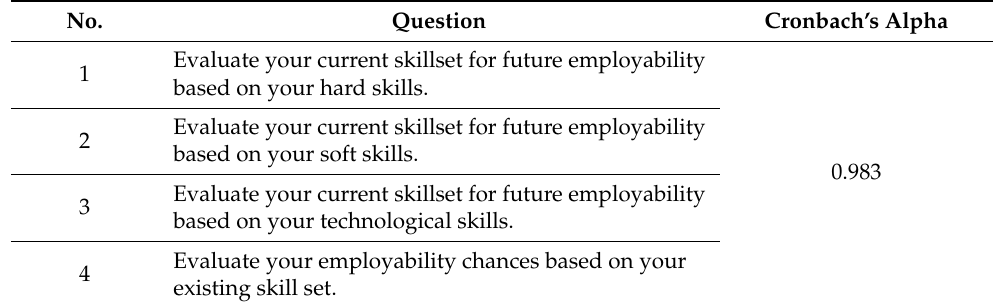
Table 3. Reliability of the quantitative questions asked in the survey.